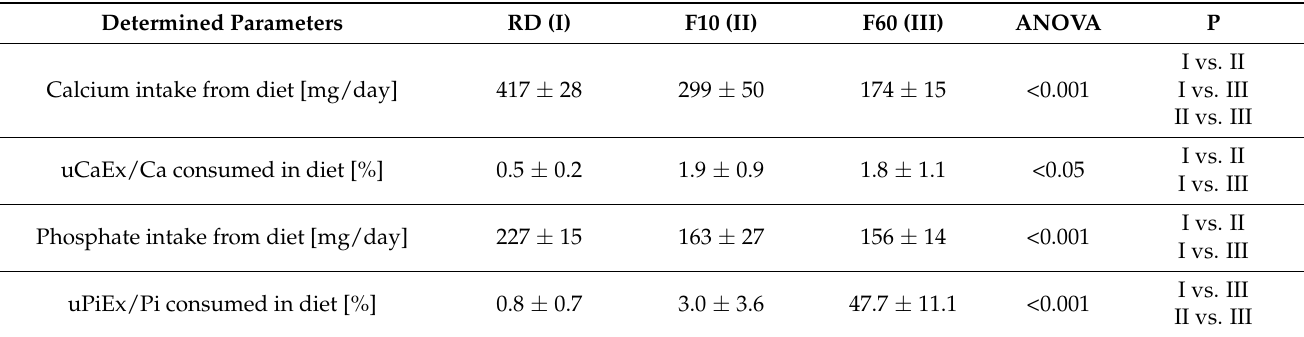
Figure 2. Pathological lesions in kidneys of rats on 10% fructose diet (F10). Basophilic deposits in area of renal medulla (arrow) (HE, magnification 20×).